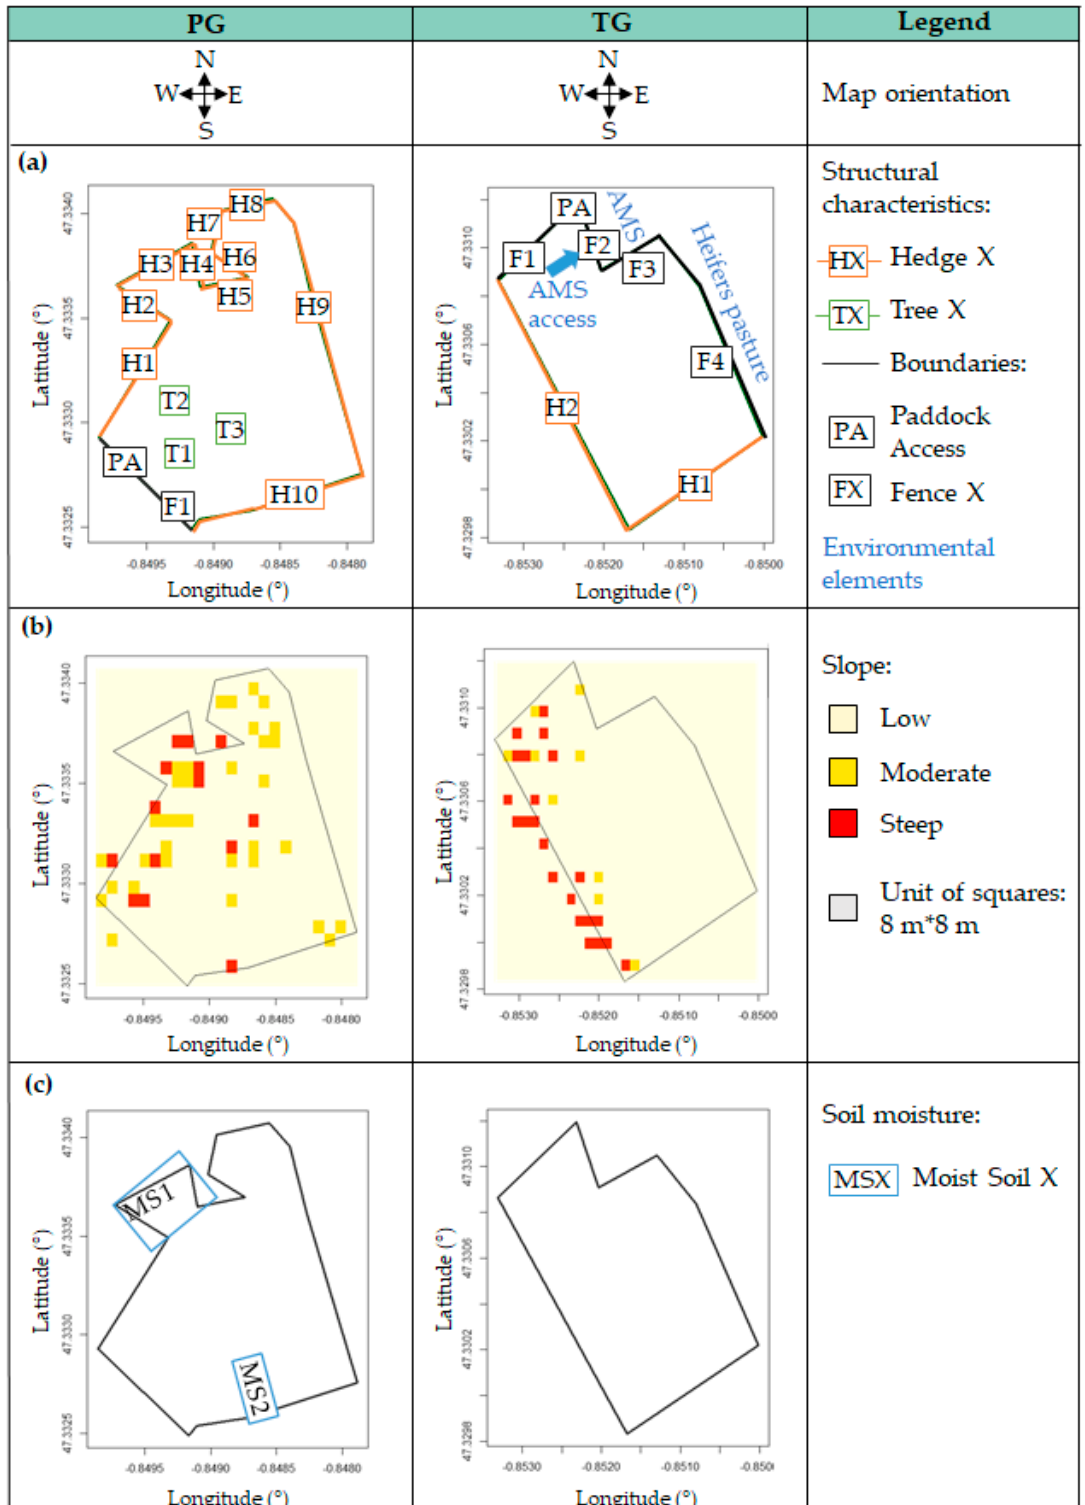
Figure 2. Description of the two paddocks grazed during the experiment based on the ( a ) structural characteristics ( b ) slope and ( c ) soil